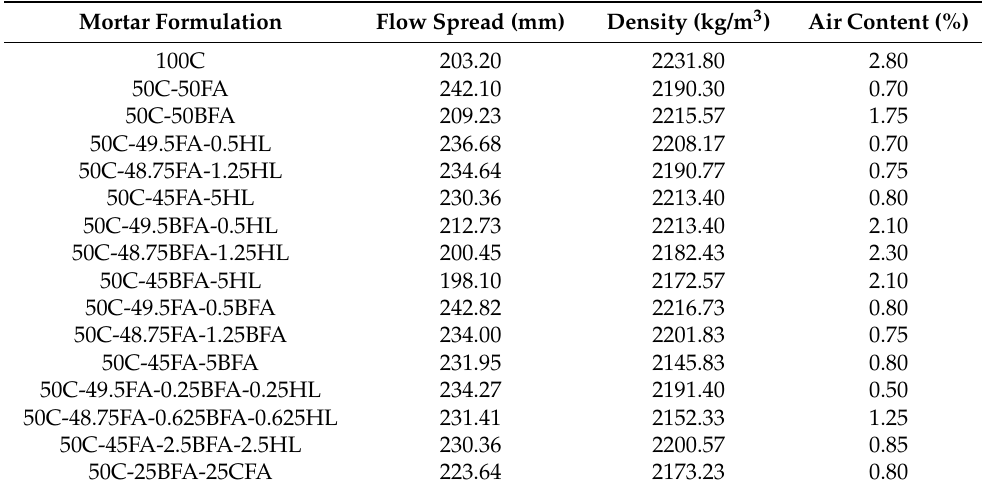
Table 4. Flow spread, density, and air content of fresh